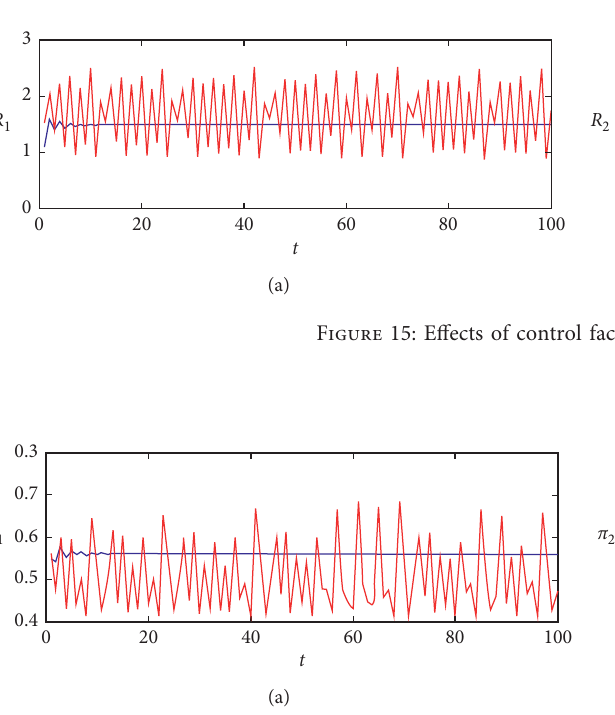
Figure 16: Effects of control factor k on π